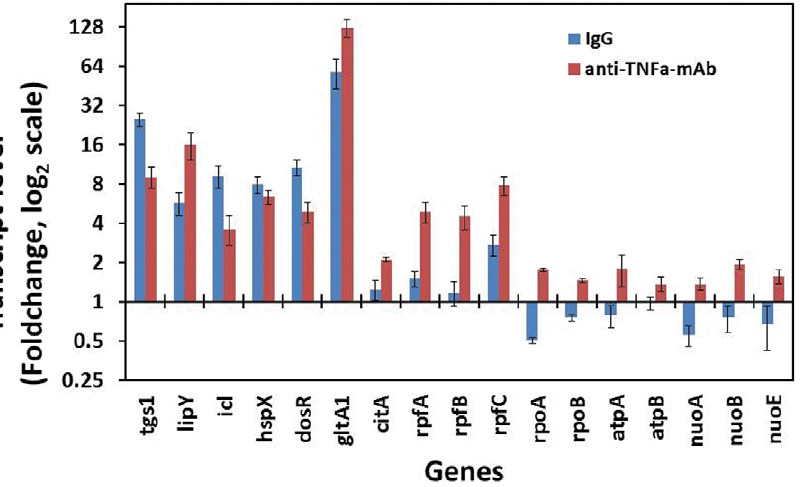
Figure 6. Gene expression profile of Mtb cells from invitro granuloma treated with IgG anti-TNF a -mAb. Relative gene expression values (fold changes of day 0) in IgG and anti-TNF a mAb treated Mtb cells are represented for a selected set of genes that are known to be involved in dormancy and resuscitation conditions. Real-time Taqman RT-PCR measurement was performed to measure relative abundance of transcripts. Relative quantitation method (ddCt) was used to determine the fold change in transcripts level. Gene transcript level is expressed as fold change in log2 scale relative to the sample from in vitro grown starter culture used for infection of PBMC. Samples of starter culture (day 0) was used as calibrator and 16S rRNA gene was used as the endogenous control to normalize the expression values. tgs1, triacylglycerol synthase1; lipY, lipase Y; icl, isocitrate lyase; hspX, heat-shock protein X; dosR, dormancy response regulator; gltA1, citrate synthase 1; citA, citrate synthase II; rpf, resuscitation promoting factor (A, B, and C); rpo, RNA polymerase (A and B); atp, ATP synthase (A and B subunits); nuo, NADH dehydrogenase (A, B and E